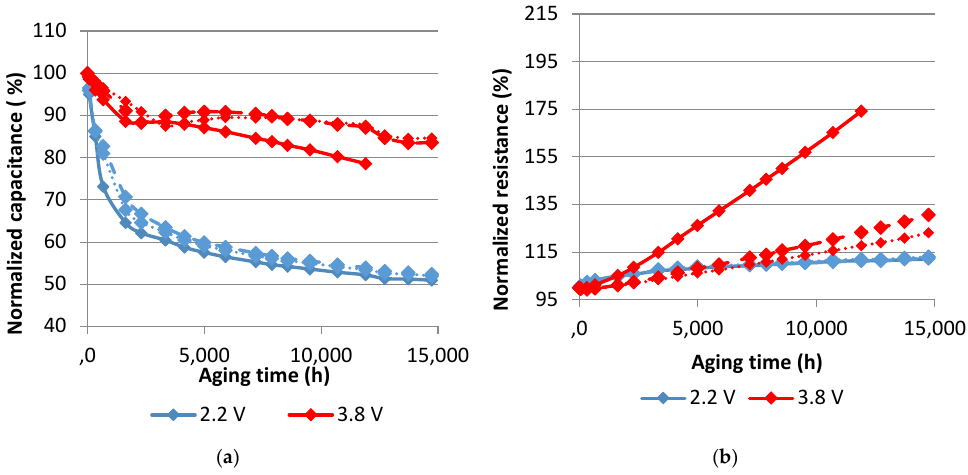
Figure 6. Evolution of the normalized capacitance ( a ) and the normalized resistance ( b ) with aging time at 60°C. Each curve represents one sample.